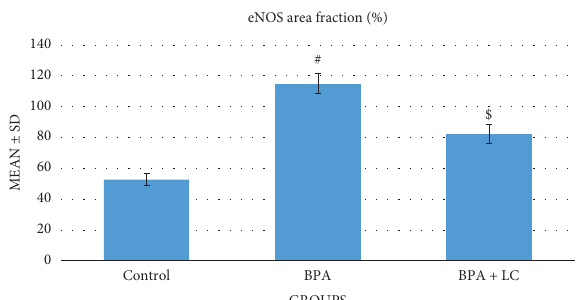
Figure 11: Graph demonstrating the quantitative analysis of eNOS expression area percentage of the heart. Data are expressed as means ± SDs. # : signifcantly diferent from the control group, while $ signifcantly diferent from the BPA group ( P < 0 .